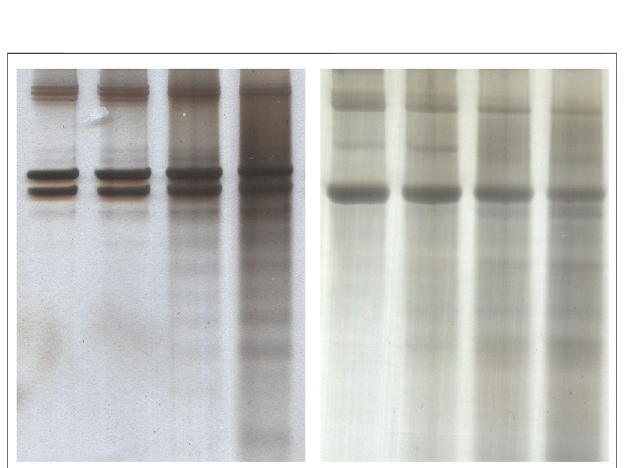
FIGURE 4| CD spectra of (A) collagen type I sonicated non-atomized, (B) collagen type Iultrasonically atomized, (C) collagen type II sonicated non-atomized, and (D) collagen type II ultrasonically atomized.